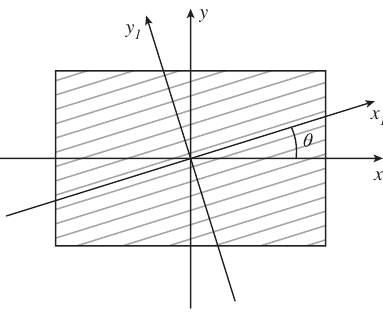
Figure 2 A layer with plate and material coordinate